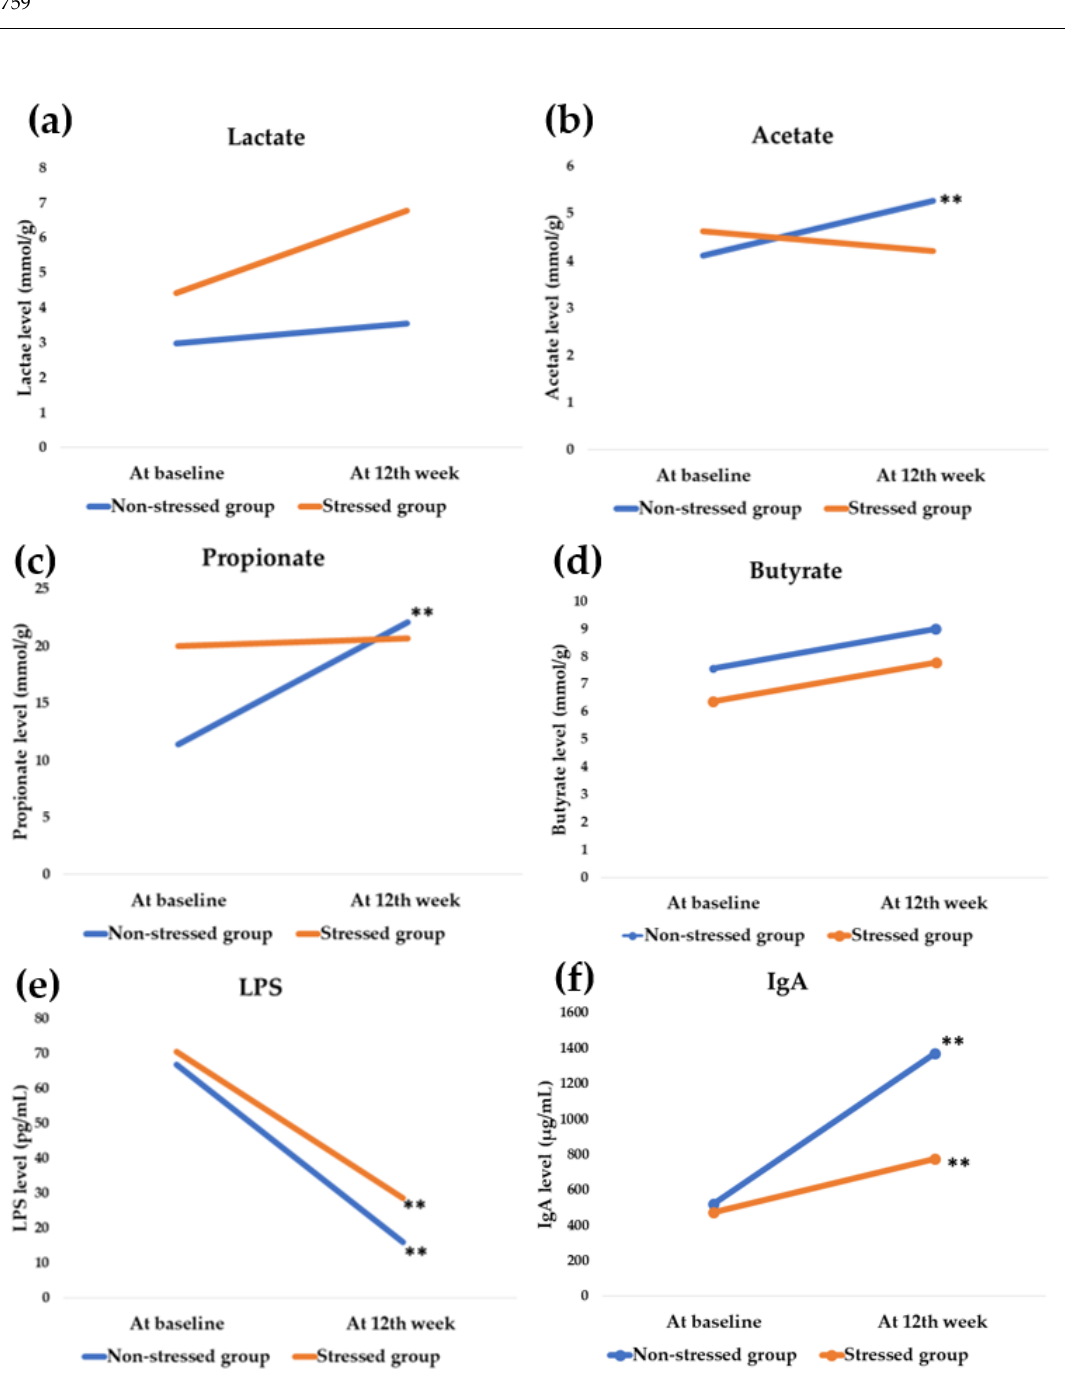
Figure 6. Effect on gut microbial metabolites. The blue and orange bar shows the values at baseline and the 12th week of synbiotics administration, respectively. ** significant difference ( p less